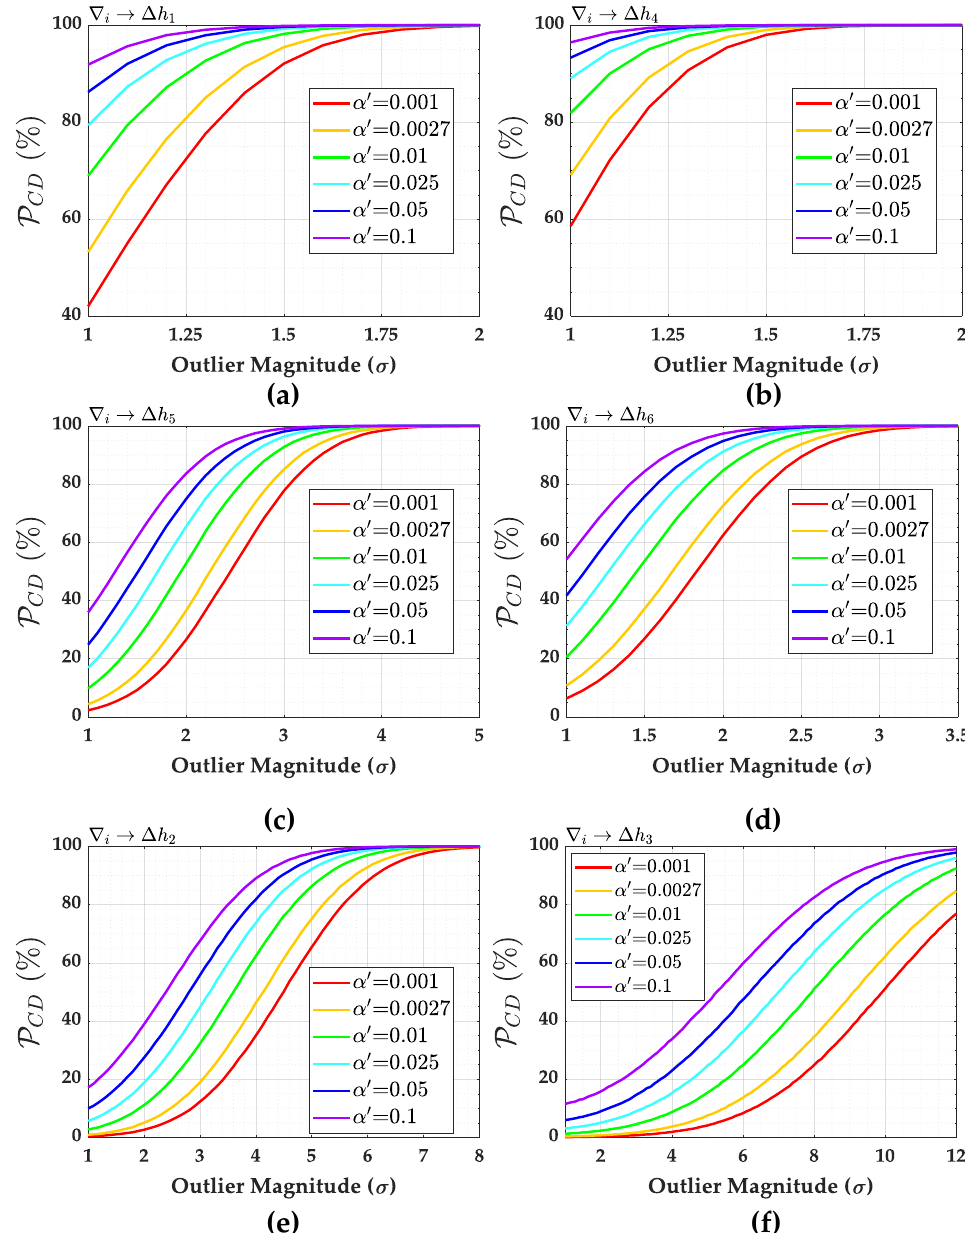
Figure 16. Probability of correct detection ( P CD ) for network ( b ). ( a ) P CD for ∆ h 1 . ( b ) P CD for ∆ h 4 . ( c ) P CD for ∆ h 5 . ( d ) P CD for ∆ h 6 . ( e ) P CD for ∆ h 2 . ( f ) P CD for ∆ h 3